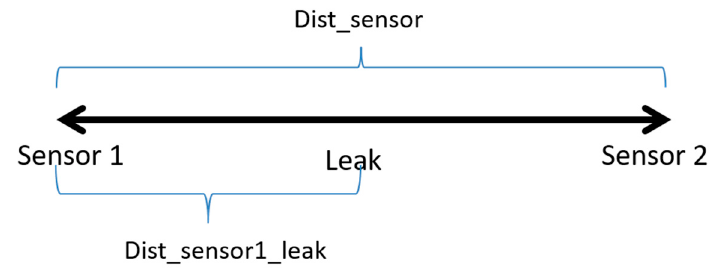
Figure 14. Schematic of leakage distance calculation from two deployed sensors.